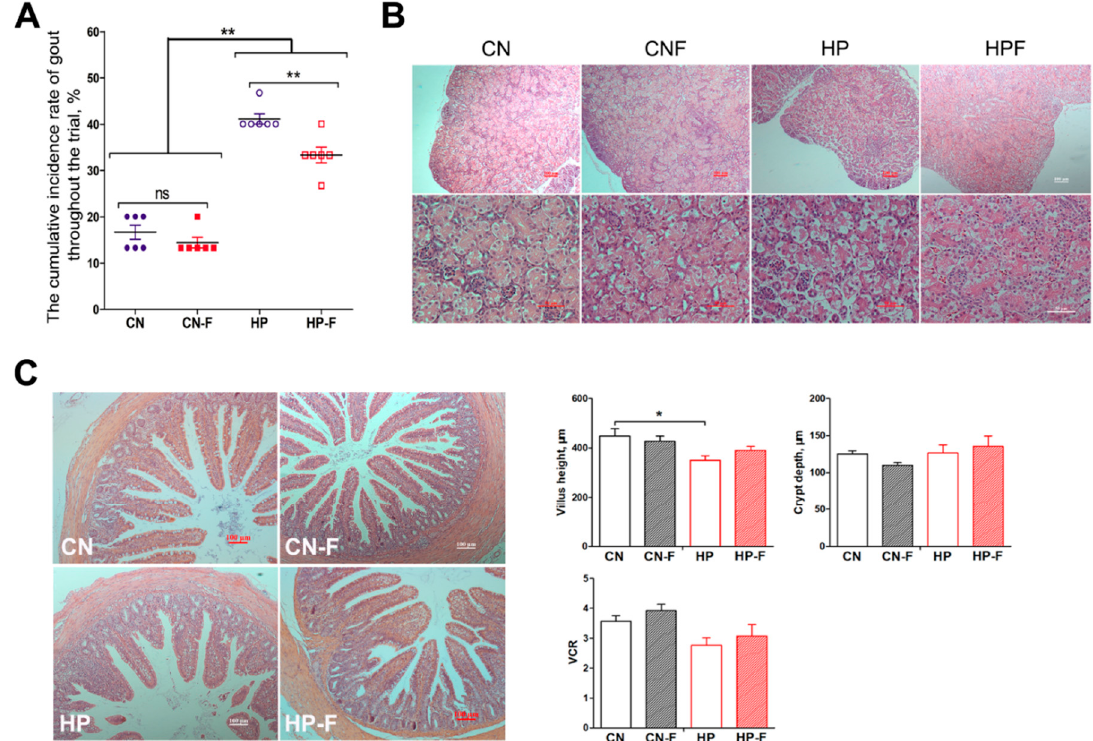
Figure 3. Evaluation of changes in renal injury and intestinal morphology in goslings among groups (groups: CN: a basal diet; CNF: replaced 5.0% basal diet with fermented feed; HP: a high-protein diet; HPF: replaced 5.0% high-protein diet with fermented feed). ( A ) The morbidity of gout in goslings among groups; ( B ) morphological observation of the kidney by HE stain (Bar = 100 µ m). ( C ) Morphological observation and of the intestinal villus among groups (HE staining, Bar = 200 µ m); ( D ) the comparisons of villus height, crypt depth, and their ratio in cecum. CN: 162.9 g / kg CP, a basal diet; CNF: 167.5 g / kg CP, replacing 5.0% basal diet with fermented feed; HP: 229.7 g / kg CP, a high-protein diet; HPF: 230.7 g / kg CP, replacing 5.0% high-protein diet with fermented feed. Asterisks represent di ff erences between groups being significant (* P < 0.05, ** P <